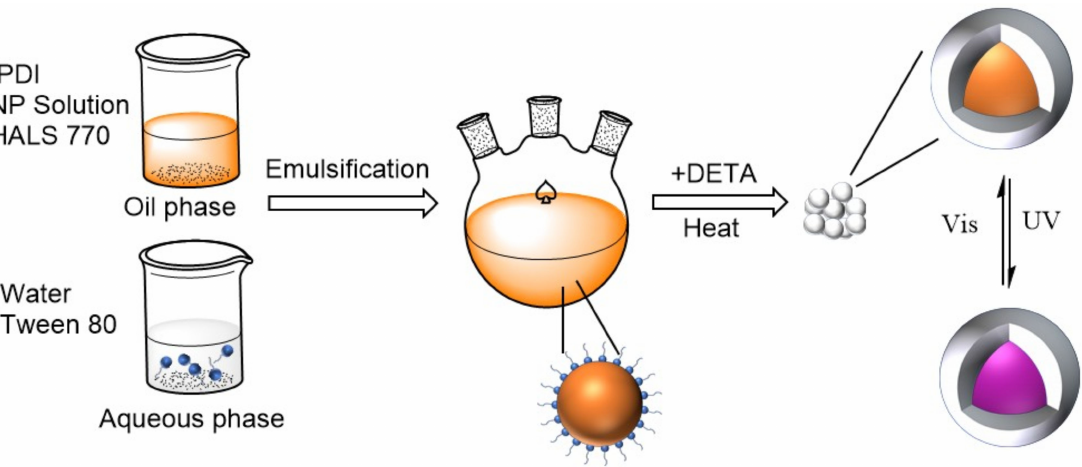
Figure 1. Scheme of the synthesis of the photochromic material